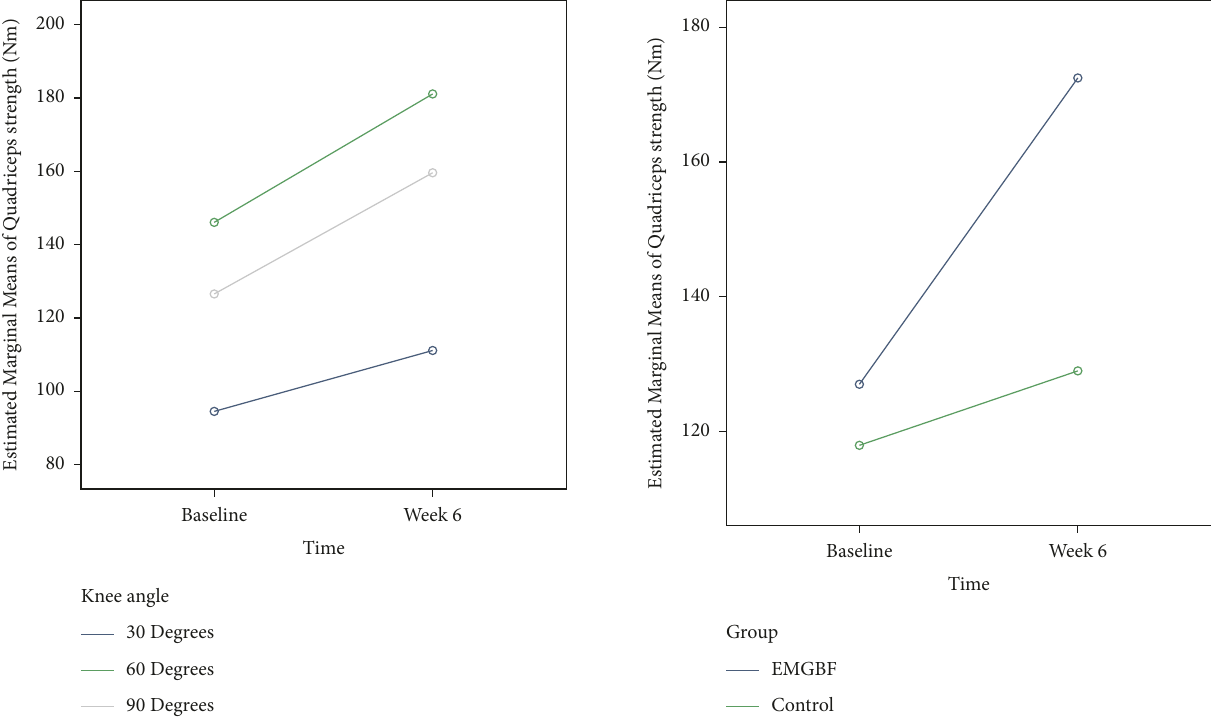
Figure 7: Comparison of quadriceps strength at different knee angles. Table 3: Summary of the results of two-way (2 Dependent variable Quadriceps muscle strength (Nm)